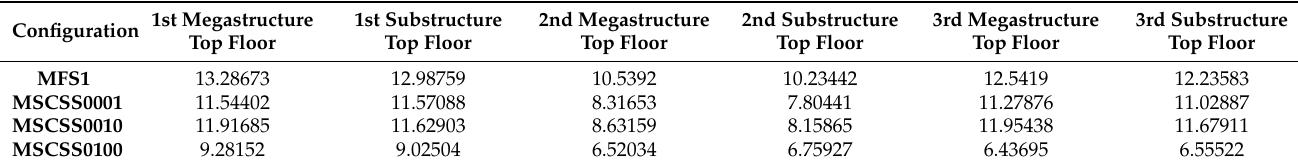
Table 8. The acceleration response at a critical point of the investigated configurations under the Tangshan wave (m s − 2 ).